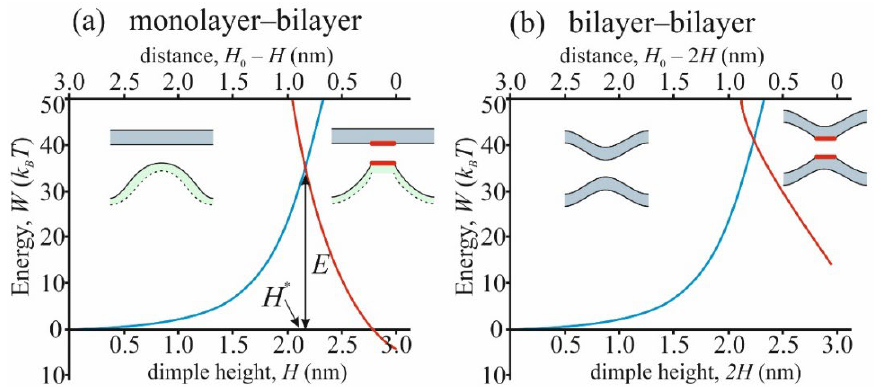
Figure 4. ( a ) The energy profile of monolayer–bilayer fusion. The dependence of the energy of the monolayer with a dimple ( W 1 , blue curve) and system with opened hydrophobic defects ( W 2 , orange curve) on the distance between the membranes ( H 0 − H ). ( b ) The energy profile of bilayer–bilayer fusion. The dependence of the energy of the bilayers with a dimple ( W 1 bil , blue curve) and system with opened hydrophobic defects ( W 2 bil , orange curve) on the distance between the membranes ( H 0 − 2 H ). Green color on the insets denotes the monolayer membrane, blue color denotes the bilayer membrane and red lines denote the hydrophobic patches.